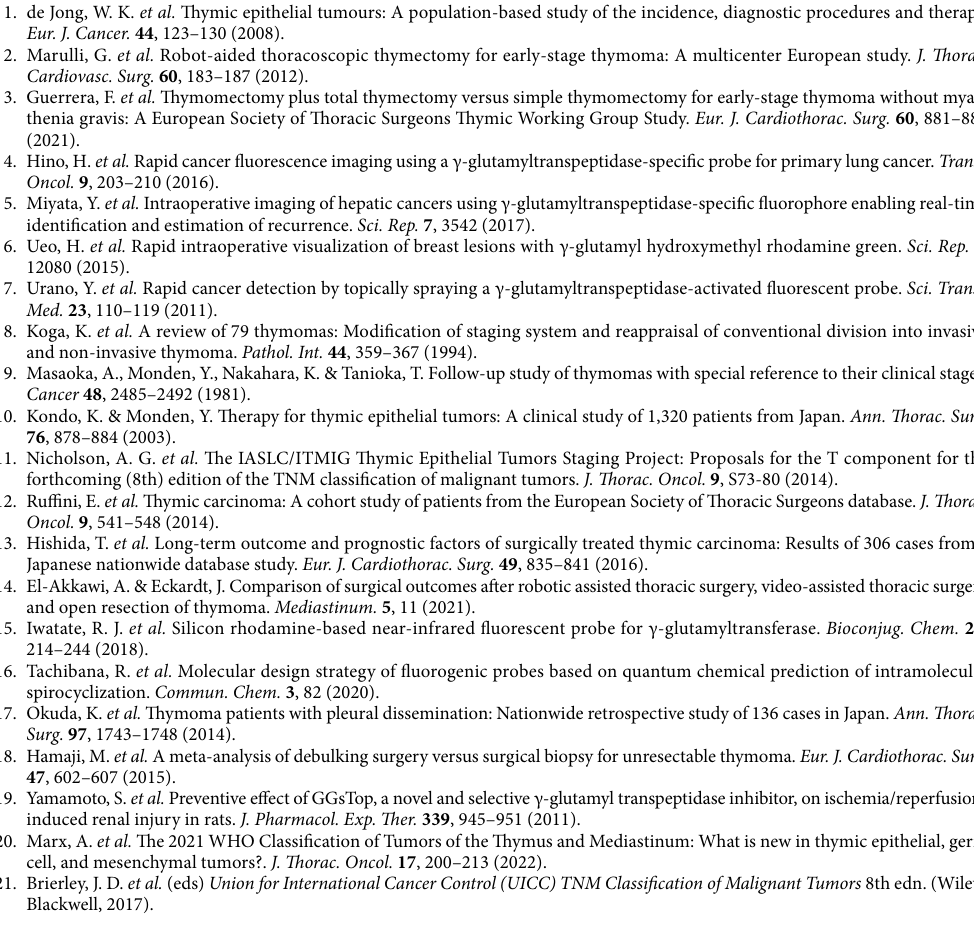
Table S3. The samples were centrifuged and each sample was measured by triplicate using a LightCycler ® 480 System II (F. Hoffmann-La Roche Ltd, Basel, Switzerland). The mRNA expression levels of GGT1 were expressed relative to internal standards and compared between tumor and normal. Statistical analysis. Statistical analyses were carried out using software R 3.3.2 (R Foundation for Statisti- cal Computing, Vienna, Austria). Sensitivity, specificity, PPV, NPV, and accuracy were evaluated from the ROC